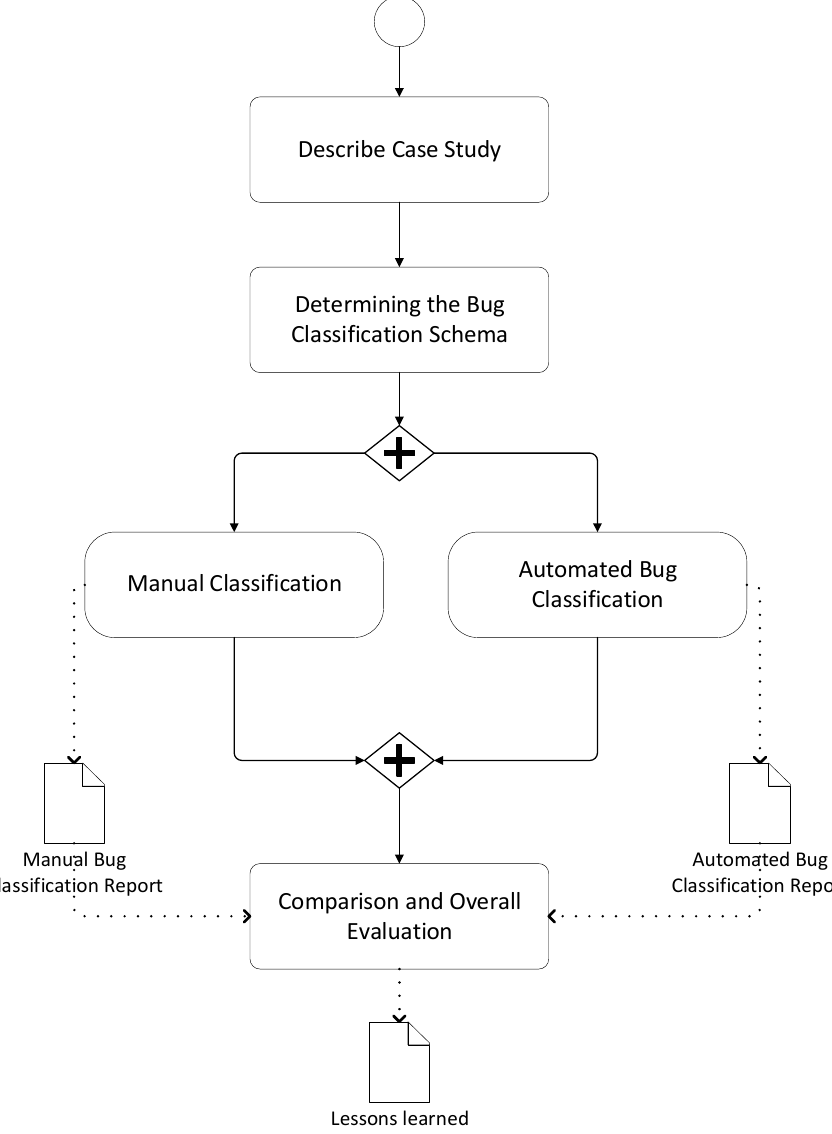
Figure 3. Adopted research methodology.